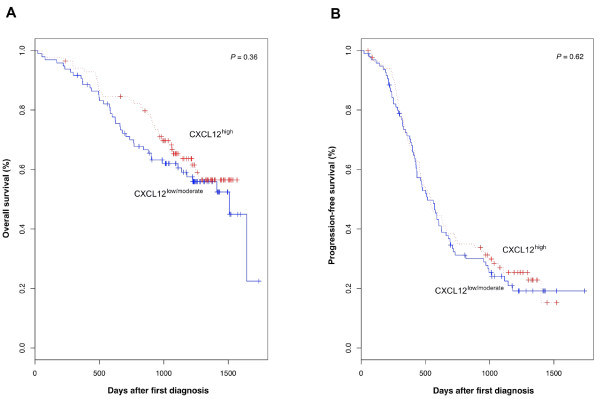
Overall survival and progression-free survival as a function of CXCL12 expression. Plots of Kaplan-Meier estimates for overall survival (A) and progression-free survival (B) of EOC patients with tumor tissues identified as CXCL12low/moderate (n = 97, solid blue line) or CXCL12high (n = 86, dotted red line). P values are those obtained in log-rank tests.